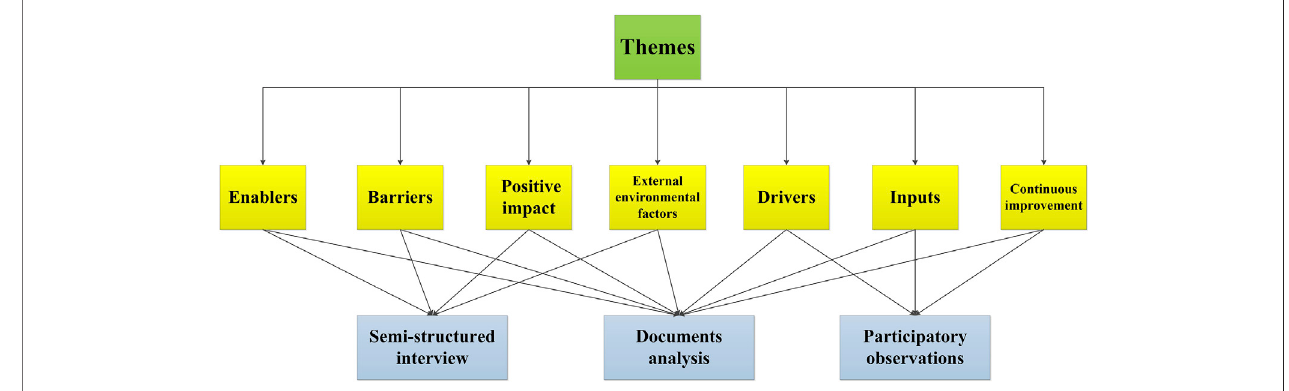
FIGURE 2 | Map of the themes and their